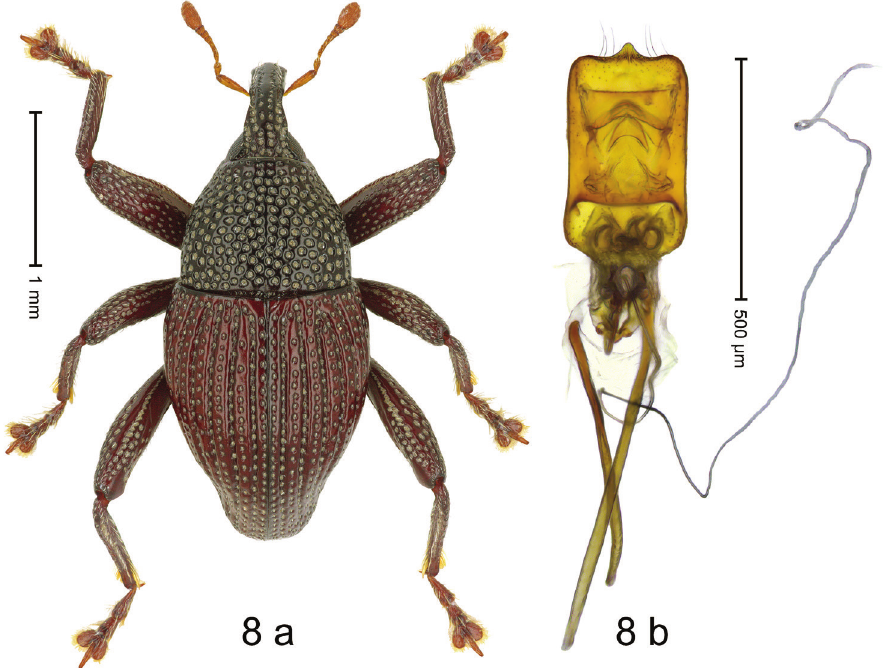
Figure 8. Trigonopterus gundala sp. nov., holotype a habitus b penis.